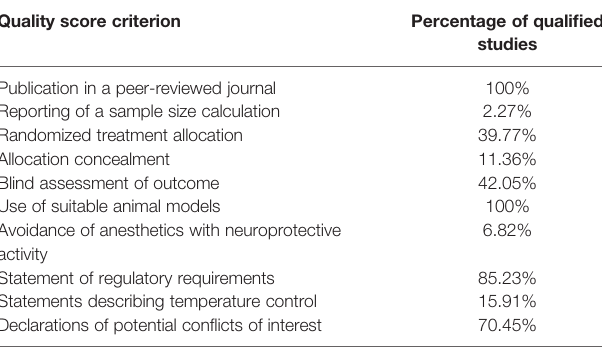
TABLE 1 | Percentage of included studies satisfying each criterion of CAMARADES